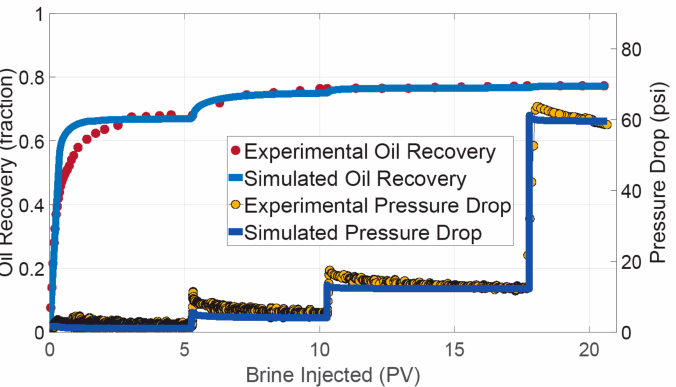
Figure 11. History matching of USS-2.